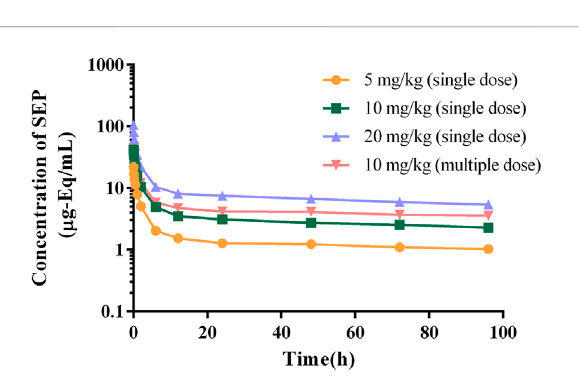
FIGURE 2 Logarithmic graph of mean plasma concentration – time pro fi les in rats after intravenous injection of SEP (single doses of 20, 40, or 80 mg/kg or multiple doses of 40 mg/kg on the seventh day).